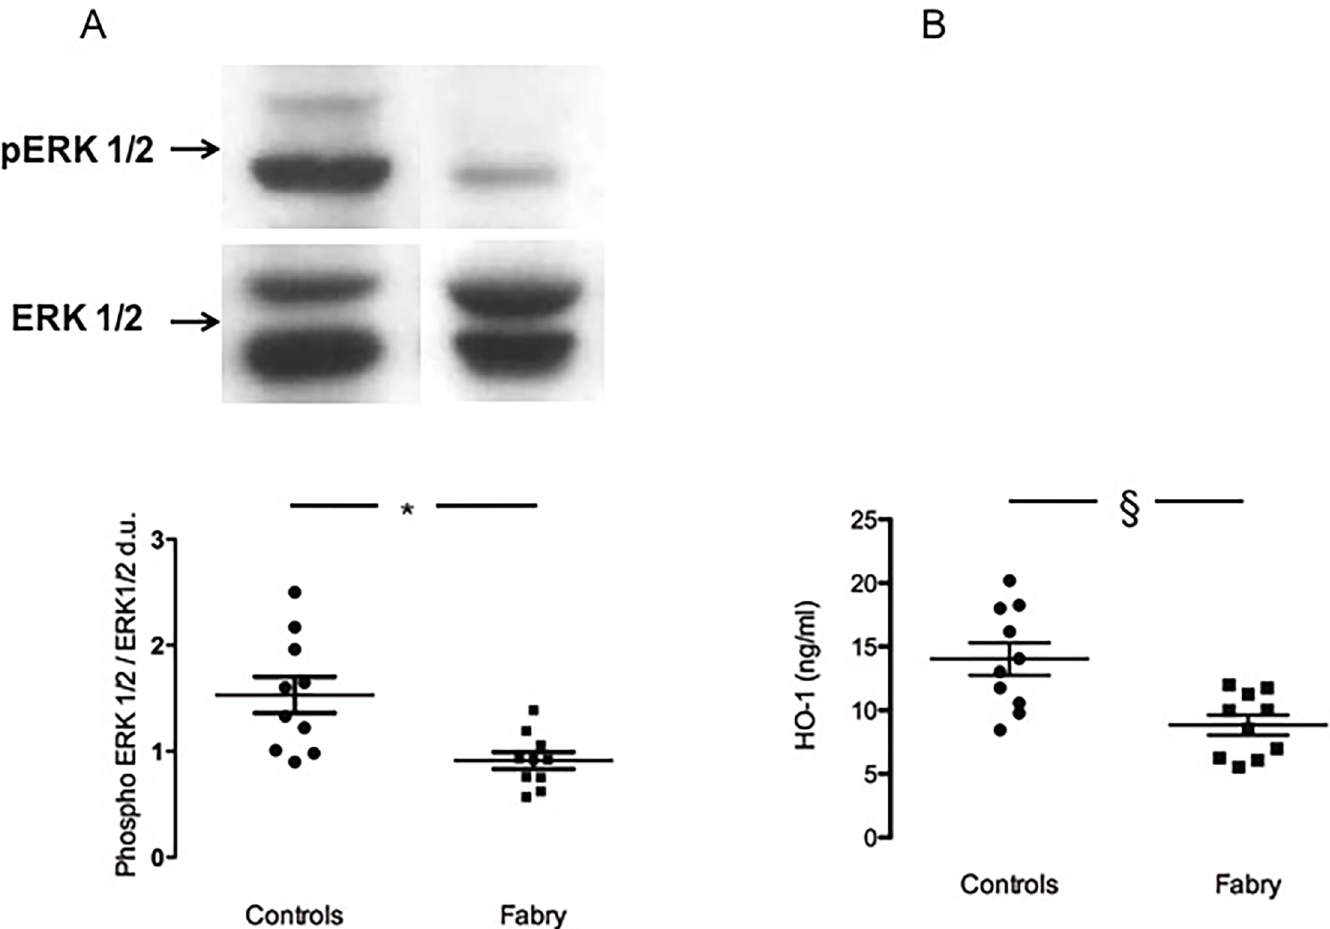
Fig 2. panel A: ERK 1/2 phosphorylation state. The top of the figure shows representative ERK 1/2 phosphorylation status in Fabry patients (Fabry) and in healthy subjects (Controls). Data are shown ± SEM. (cid:3) : p = 0.004. panel B: HO-1 protein expression. HO-1 protein concentration (ng/mL). Data are shown ± SEM. §: p <